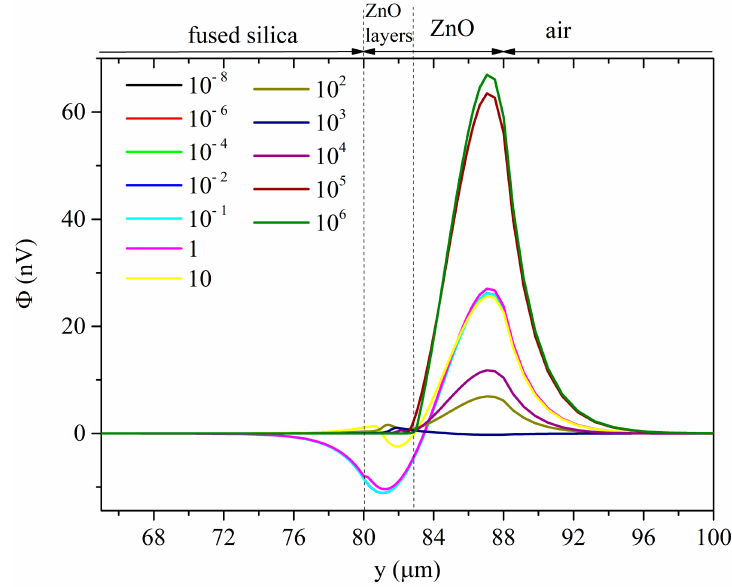
Figure 18. The electric potential distribution under the Sezawa mode at some conductivity values, under bottom illumination, and when δ UV = 200 nm.